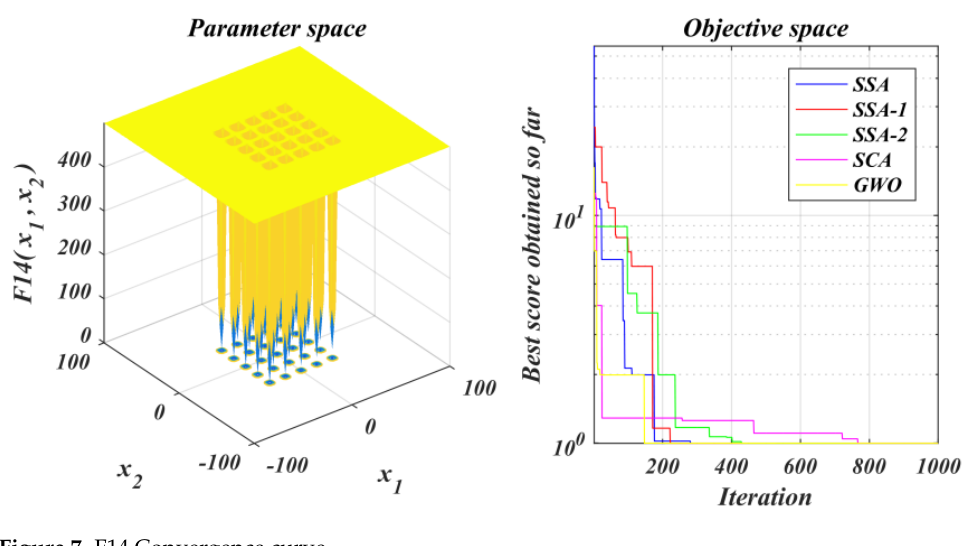
Figure 6. F13 Convergence curve.